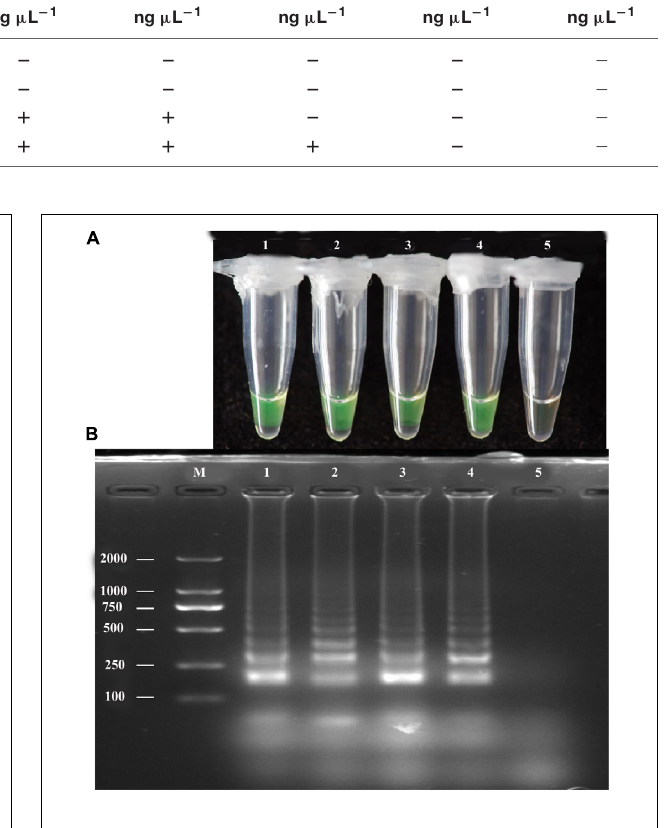
FIGURE 4 | LAMP assay tested for diluted Pure cultures. (A) Visual inspection of three different diluted pure cultures of A. solani was tested for LAMP assay without DNA extraction. (B) Analysis of the LAMP products by 2% agarose gel electrophoresis. Lane M: DL2000-bp DNA marker; Lane 1–3: different A. solani isolates from different geographic areas; Lane 4: positive control ( A. solani genomic DNA); Lane 5: negative control. Similar results were observed in three repeat